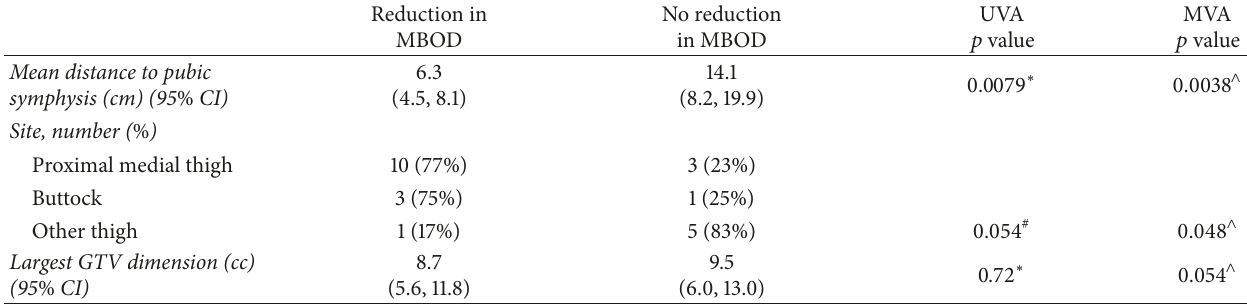
Table 4: Univariate and multivariate analysis of likelihood of reduction in mean bilateral ovary dose (MBOD) with an ovary-sparing